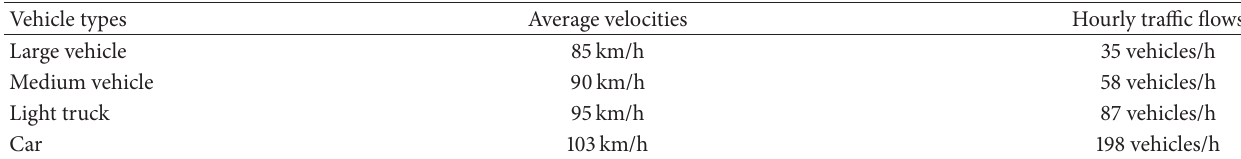
Table 6: Vehicle velocities and hourly traffic flows used as evaluation data.